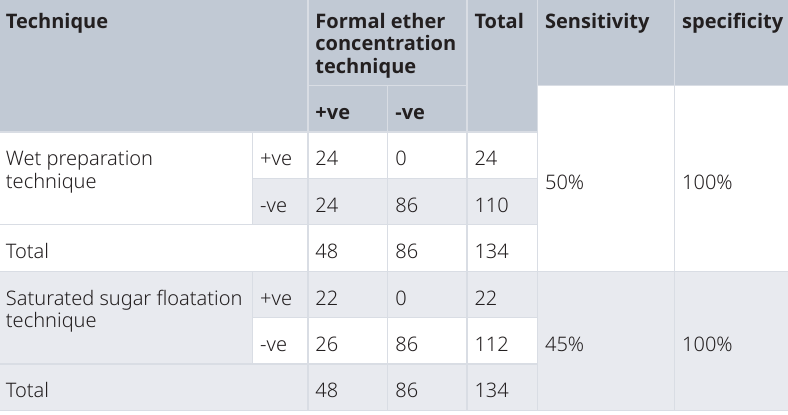
Table 6. Sensitivity and specificity of techniques compared with formal ether.